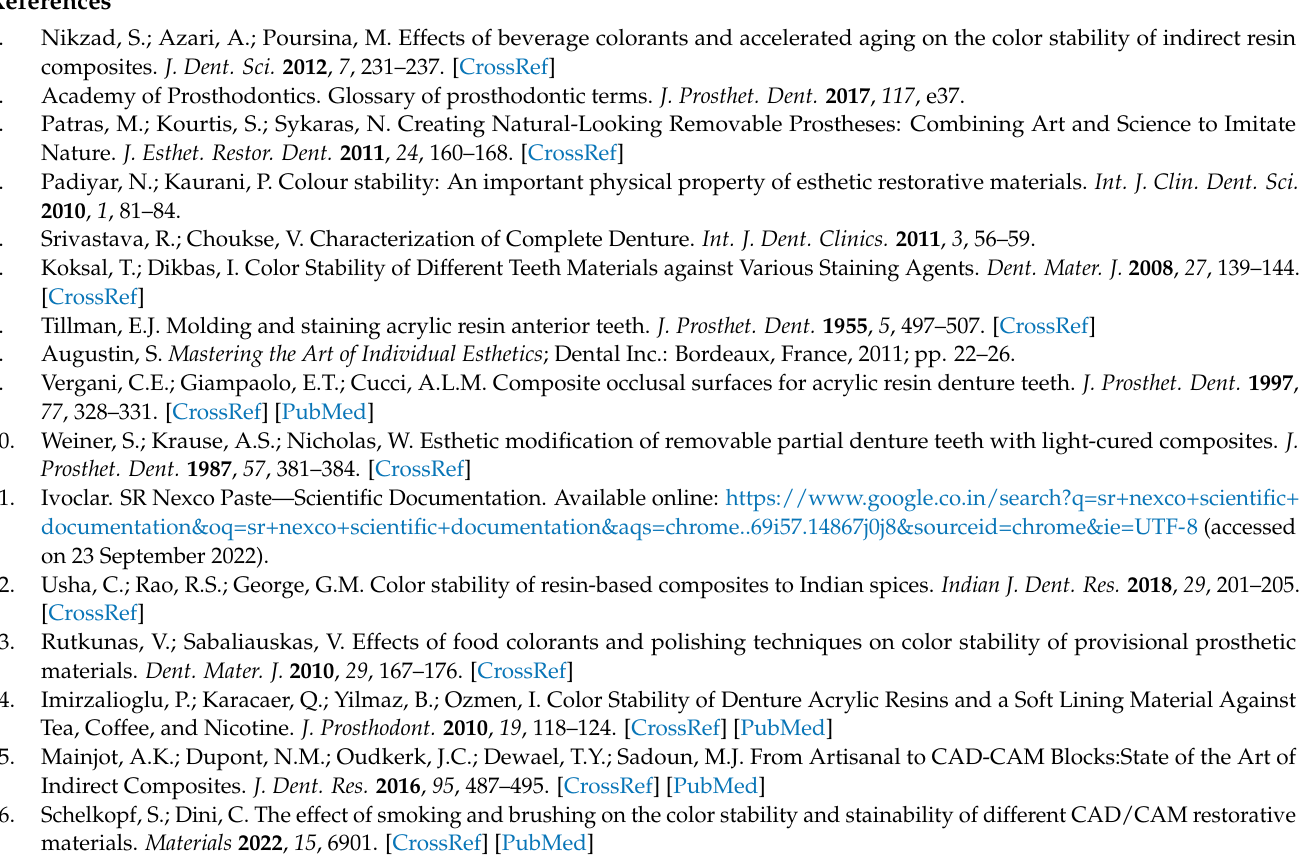
and after immersion. Table S2: Overall comparison of difference in ∆ E between the groups. Table S3: Comparison of difference in ∆ E in between the subgroups. Table S4: Comparison of ∆ E difference in each staining solution between composite materials. Table S5: National Bureau of Standards (NBS) system of expressing color